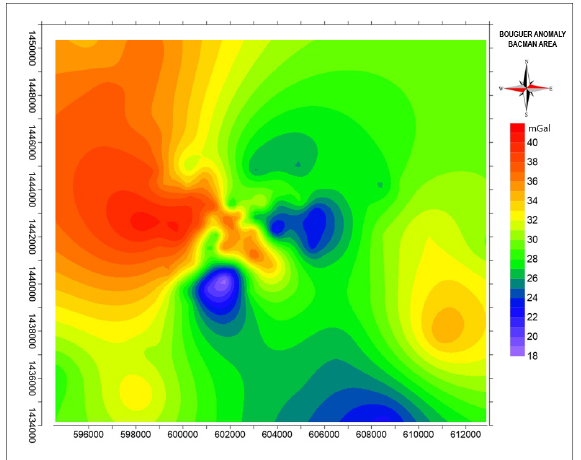
Fig. 9. Map of the Bouguer Residual anomaly of the Bac-Man geothermal